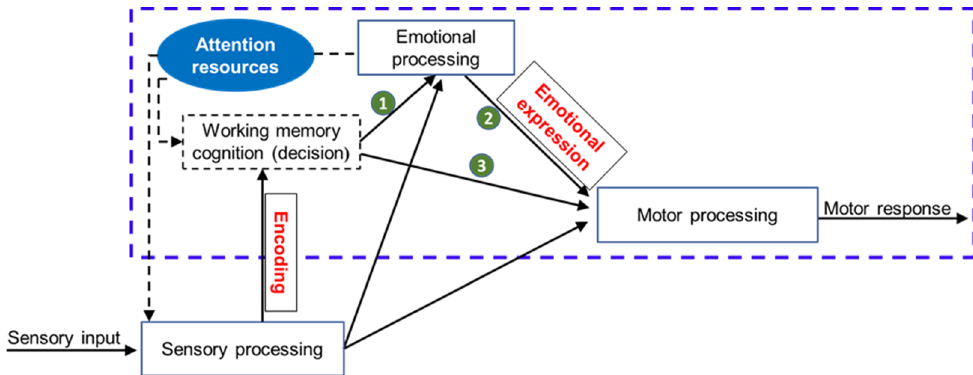
Figure 2. Summary of sensory–motor processing with sensory, emotional, and motor components, from detection of sensory input to response. Note: One theory views SOR from the perspective of sensory–motor processing. Sensory inputs (sensory signals) first enter sensory processing for registration, detection, and encoding. Next, the signals enter emotional processing for emotional expression (e.g., negative emotions, such as crying) or enter motor processing (e.g., they elicit a motor response to express an emotion or respond to sensory signals) based on previous memory or cognition. To help children adapt to their environment, an intervention involving top-down regulation (e.g., bringing attention to or away from these signals—the box outlined in blue dashes) may lead to the selection of an appropriate behavioral response (e.g., emotional expression or motor response). Such intervention may elicit responses in various configurations: the cognition–emotion process (green number 1; PA, CMBT), the emotion–motor process (green number 2; PA, SIT, MBT, CMBT), and the cognition–motor process (green number 3; SIT, CMBT). CMBT = cognitive-behavioral therapy; MBT = mindfulness-based training; PA = physical activity; SIT = sensory integration